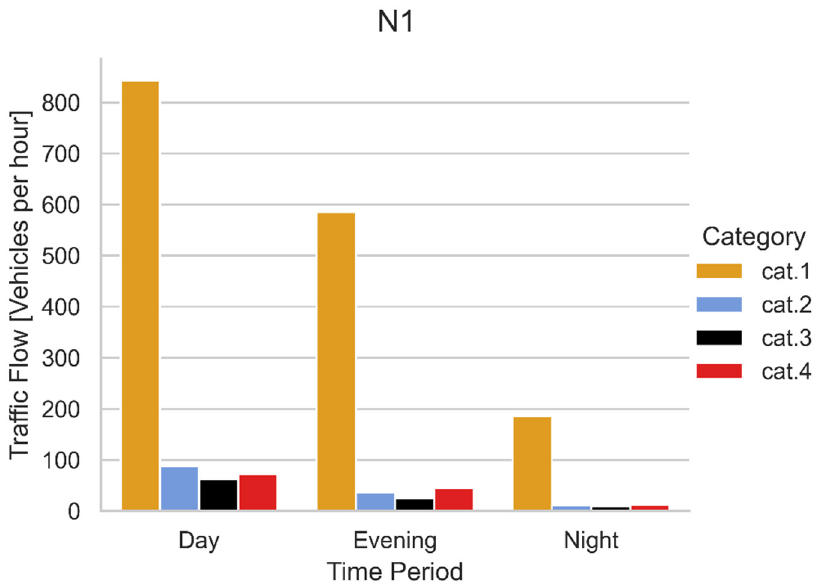
Figure 10. Traffic flow divided for categories of CNOSSOS-EU [15] and period of the day measured in N1 position in 2021.